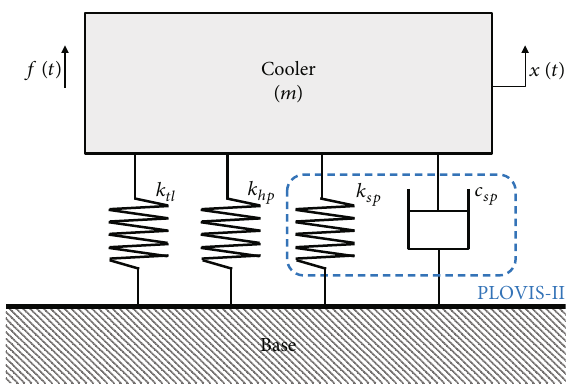
Figure 4: Simpli fi ed mathematical model of cooler assembly with